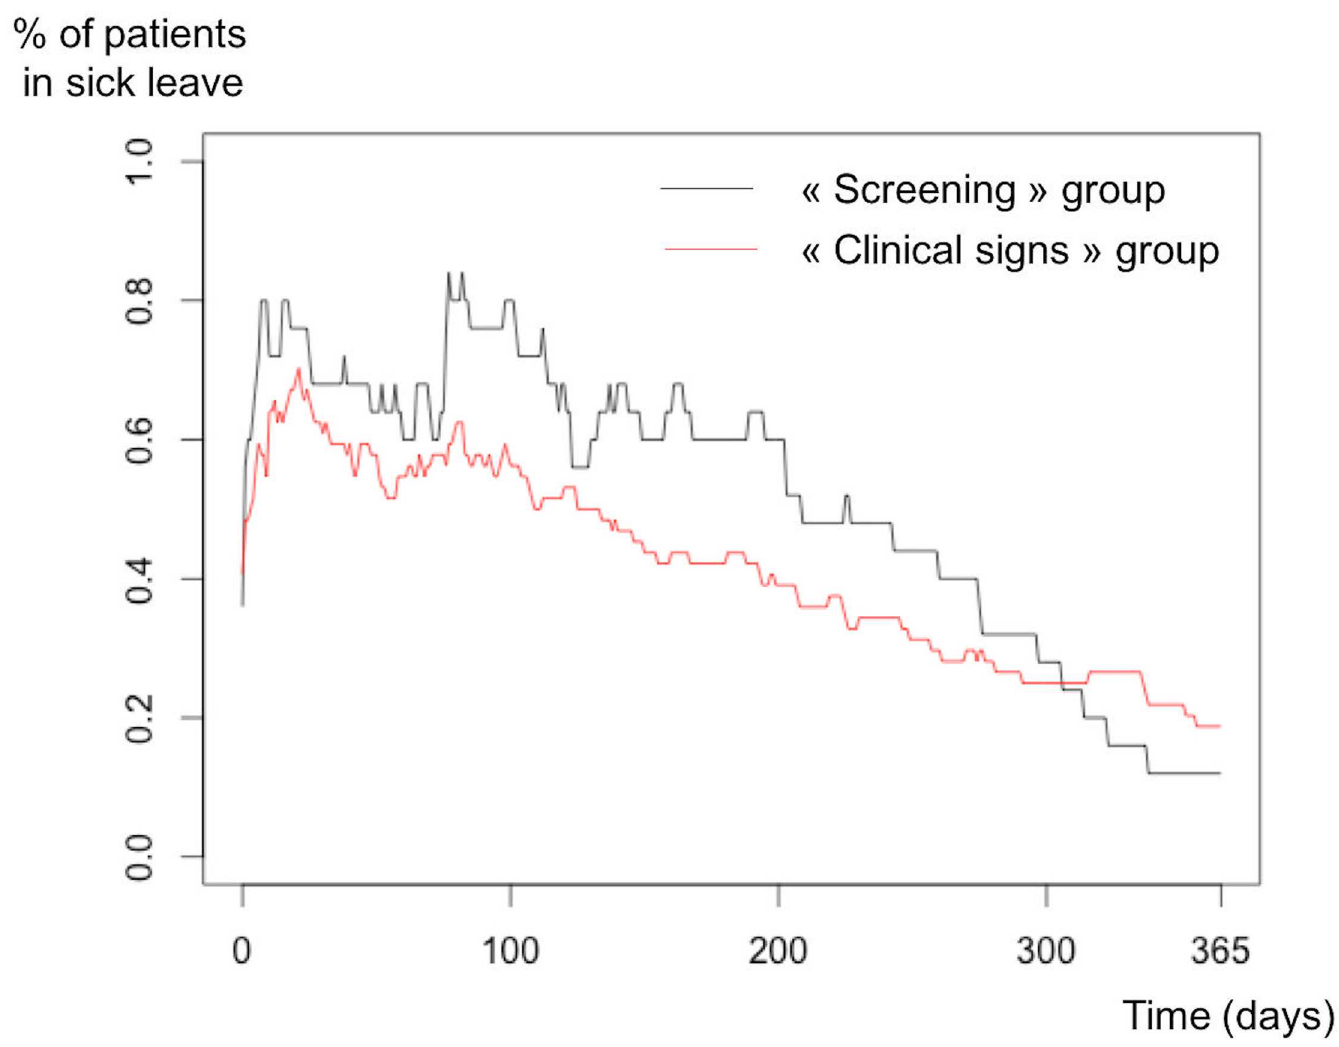
Fig 2. Duration of sick leave in the “Clinical signs” group and the “Screening”